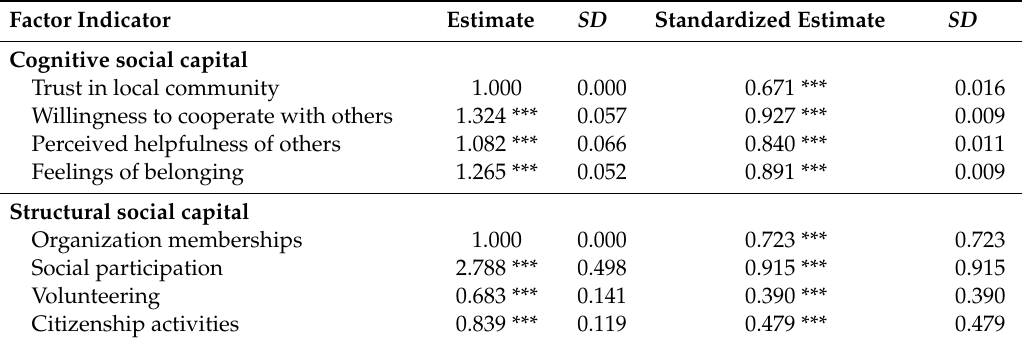
Table 2. Measurement model of social capital.